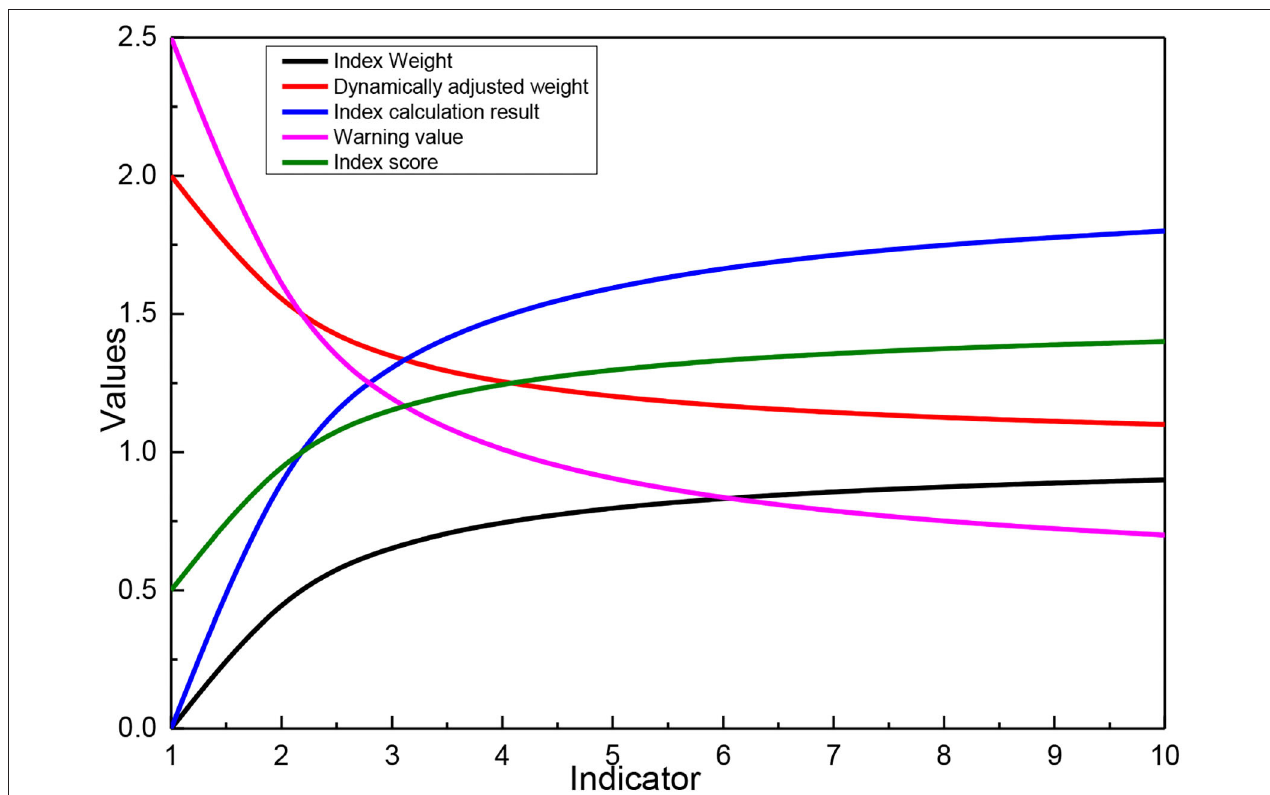
FIGURE 8 | Optimized risk model identification